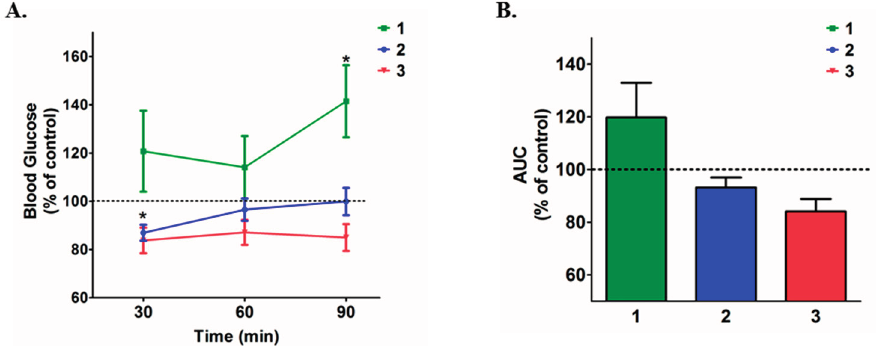
Figure 2. ( A ) Effect of a single intraperitoneal dose of 1 , 2 and 3 (3.0 mg/kg) on the blood glucose levels and ( B ) on area under the blood glucose response curve (AUC). Blood glucose levels and the AUC was calculated and expressed as percentage of saline treated group (mean ± SEM). * p < 0.05 vs.